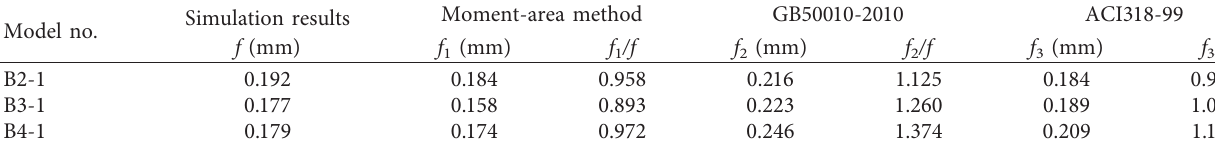
Table 6: Comparison of the inverse arch deflections of the prestressing force. Model